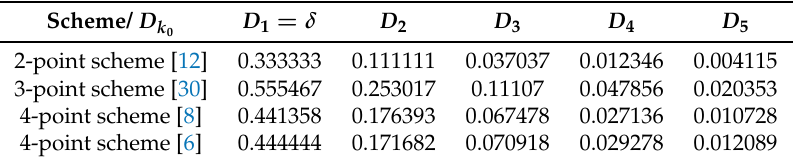
Table 1. Associated constants of ternary subdivision